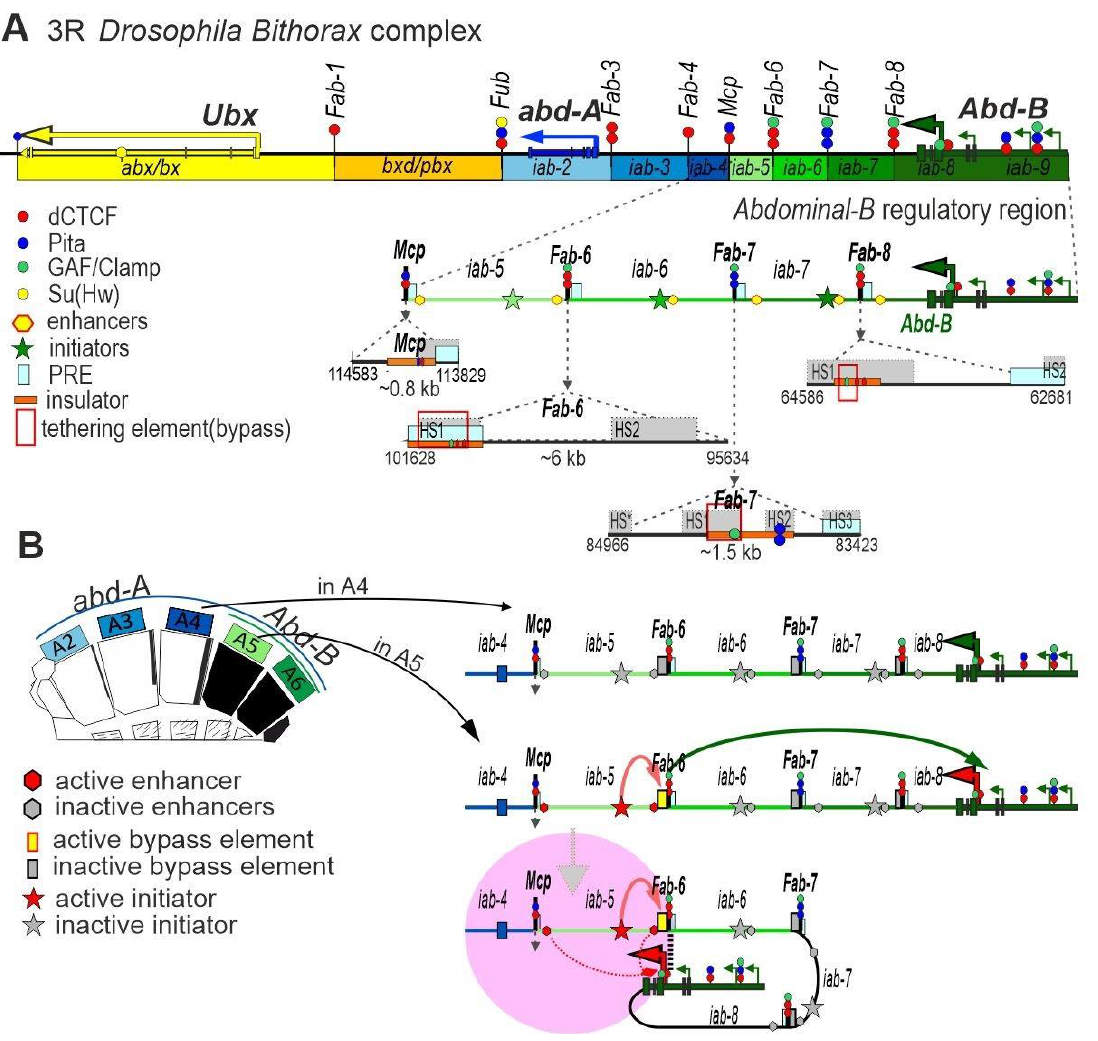
Figure 5. Boundaries organize enhancer–promoter interactions in the Abd-B gene of the BX-C. ( A ) Map of the BX-C showing the location of the three homeotic genes and the parasegment-specific regulatory domains. There are nine cis -regulatory domains (shown as colored boxes) that are responsible for the regulation of the BX-C genes and the specification of parasegments 5 to 13, which correspond to T3-A8 segments. The abx/bx (yellow) and bxd/pbx (orange) domains activate Ubx , iab-2–iab-4 (shades of blue) activates abd-A , and iab-5 – 9 (shades of green) activates Abd-B . Lines with colored circles mark chromatin boundaries. The dCTCF, Pita, and Su(Hw) binding sites at the boundaries are shown as red, blue, and yellow circles, respectively. ( B ) Model of Abd-B activation in A5/PS11. The active chromatin zone is marked in